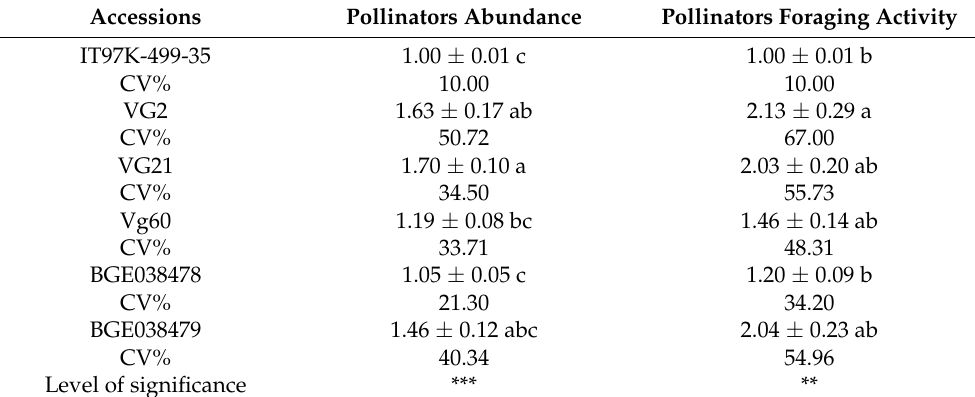
Table 4. Pollinators abundance, foraging activity and coefficients of variation (CV%) of each accession and trait. Means ± SE in columns with different letters are statistically significantly different at the 0.05 level, by Tukey’s HSD means comparison method. Accessions Pollinators Abundance